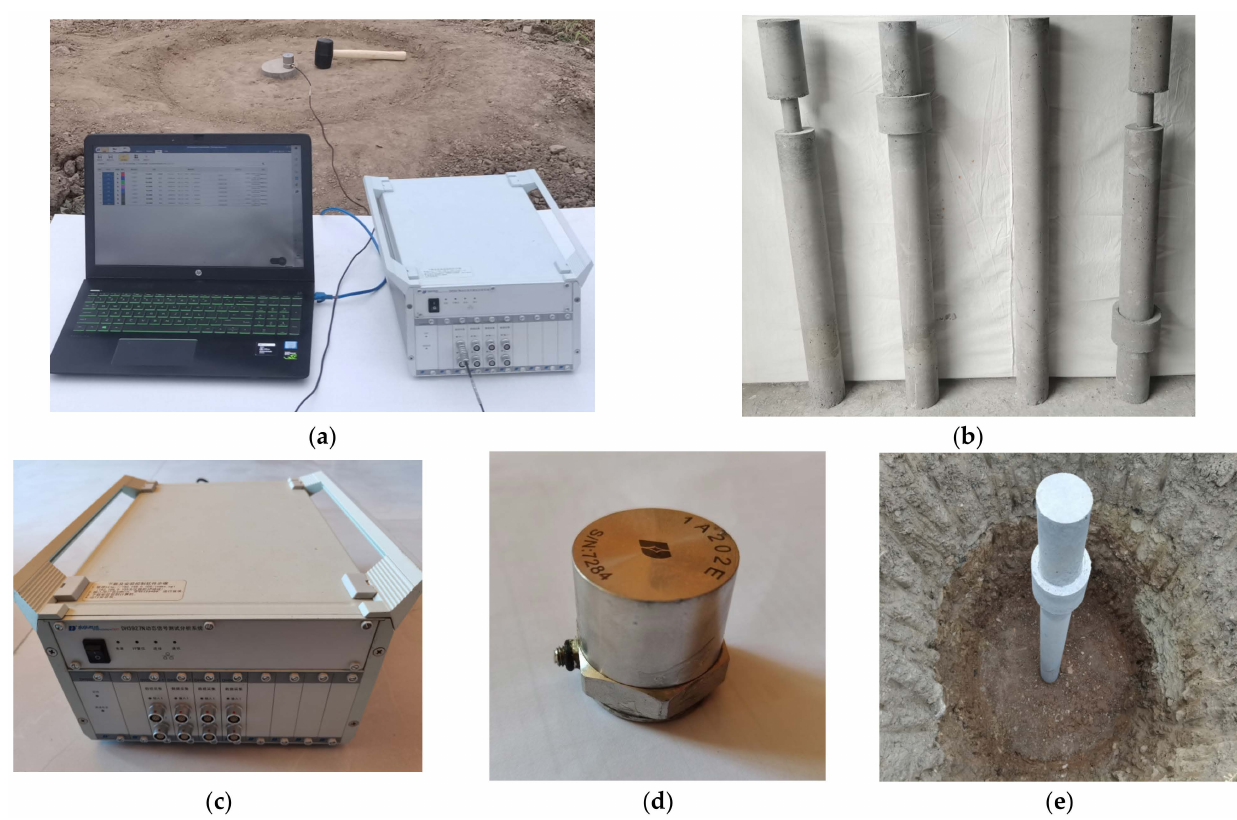
Figure 6. Experiments and models. ( a ) Test system; ( b ) Experimental model; ( c ) Signal acquisition equipment; ( d ) Sensor; ( e ) Example of defect pile